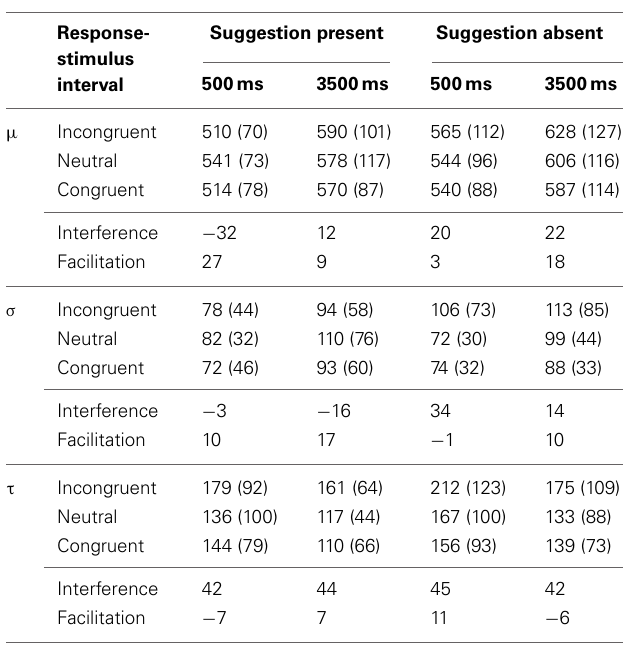
Table 3 | Estimates of the ex-Gaussian parameters (in ms; SDs in brackets) μ , σ , and τ as a function of condition.